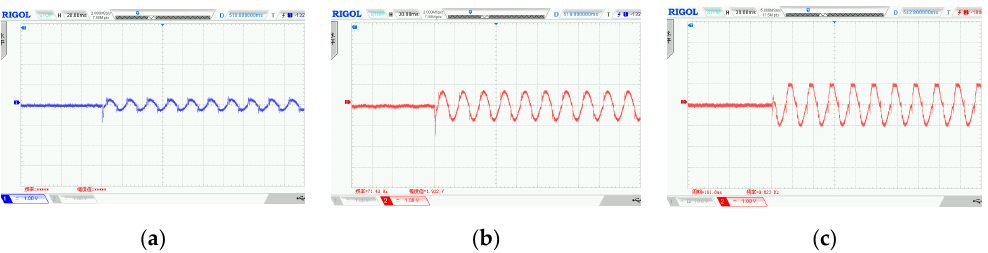
Figure 19. Experimental results of zero-sequence currents when a single-phase earth fault occurs on the end of the third feeder: ( a ) first feeder; ( b ) second feeder; and ( c ) third feeder.